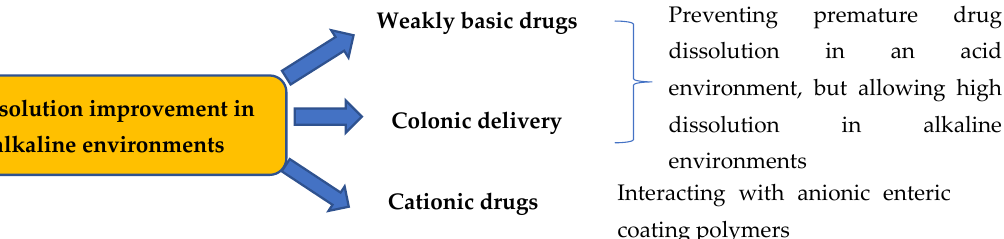
Figure 2. The ability to incorporate poorly water-soluble drugs in SDs using insoluble carriers at low pH levels.